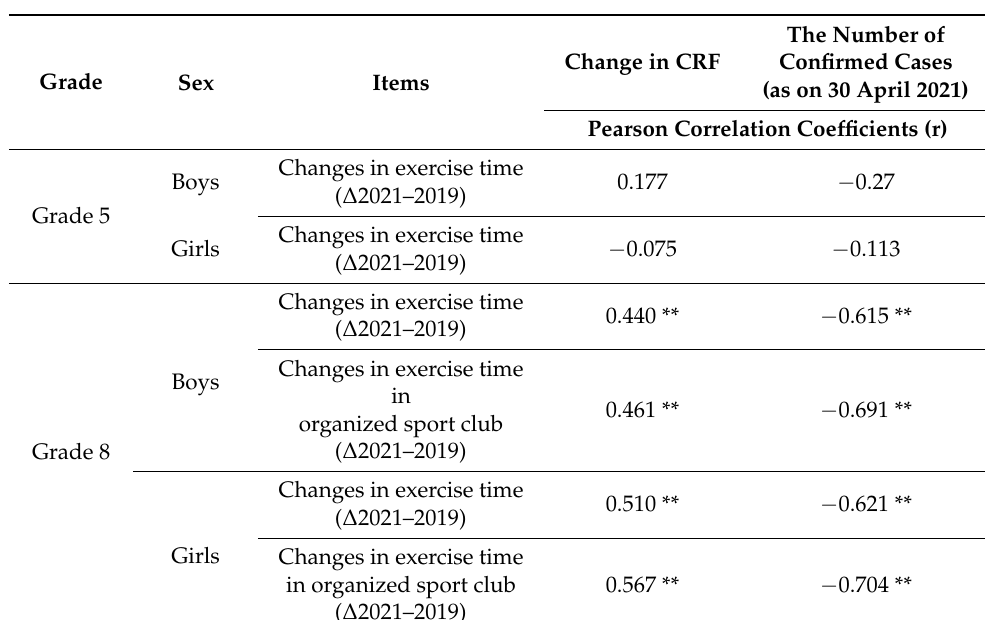
Figure 4. Changes in CRF according to Grade and sex between 2019 and 2021. Table 2. Association among change in exercise time, change in CRF, and the number of con- firmed